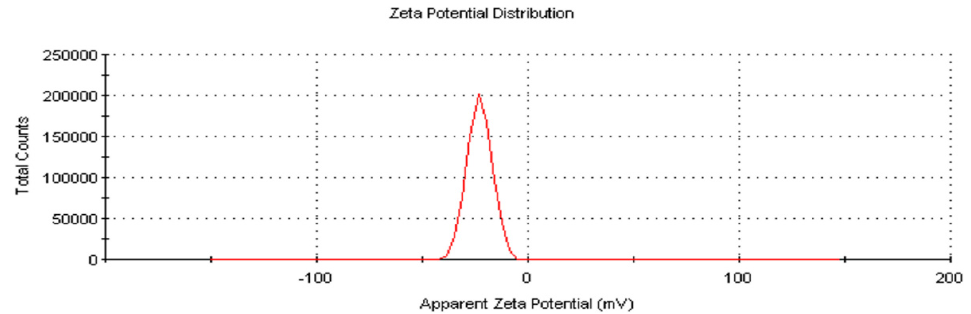
Figure 10. Zeta potential pattern of AC-AgNPs.